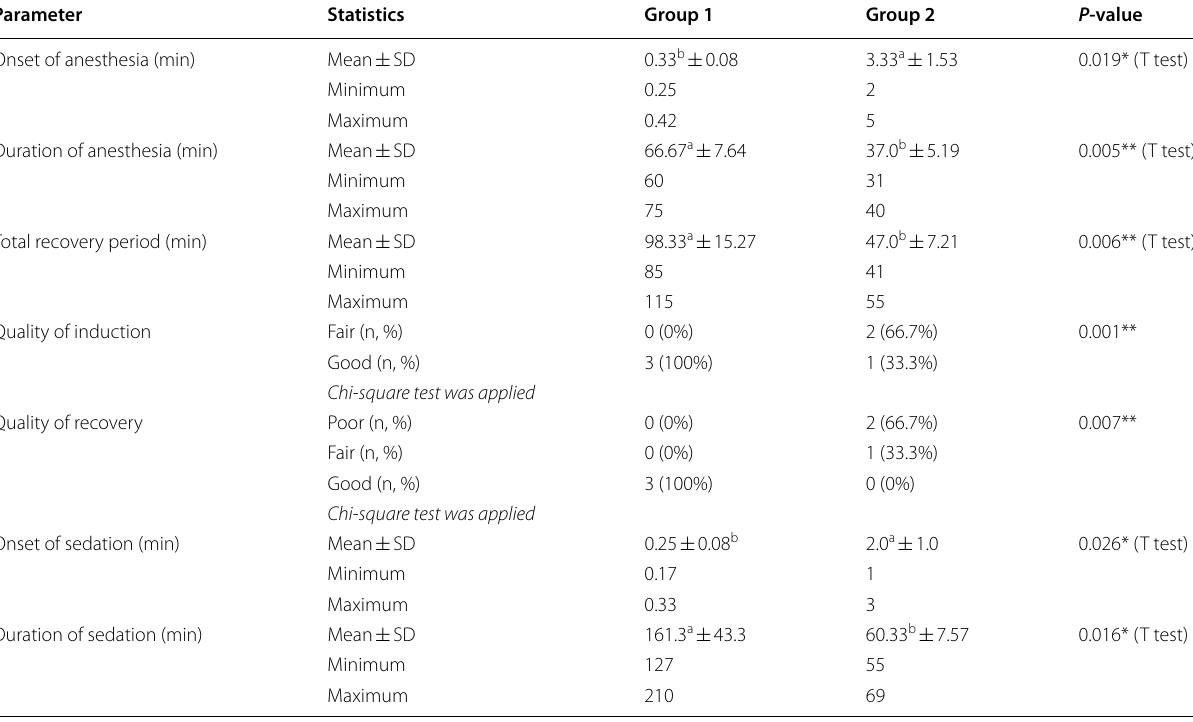
Table 6 Mean standard deviation (SD) of clinical parameters between the two groups ±